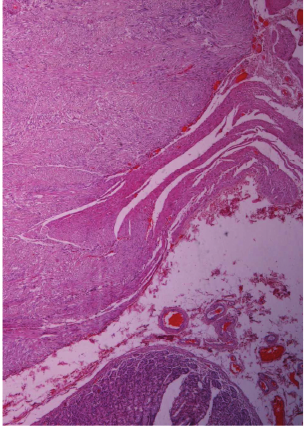
Figure 1: Colon adenocarcinoma (H/E × 100). Figure 2: Gastric GIST (H/E × 40).